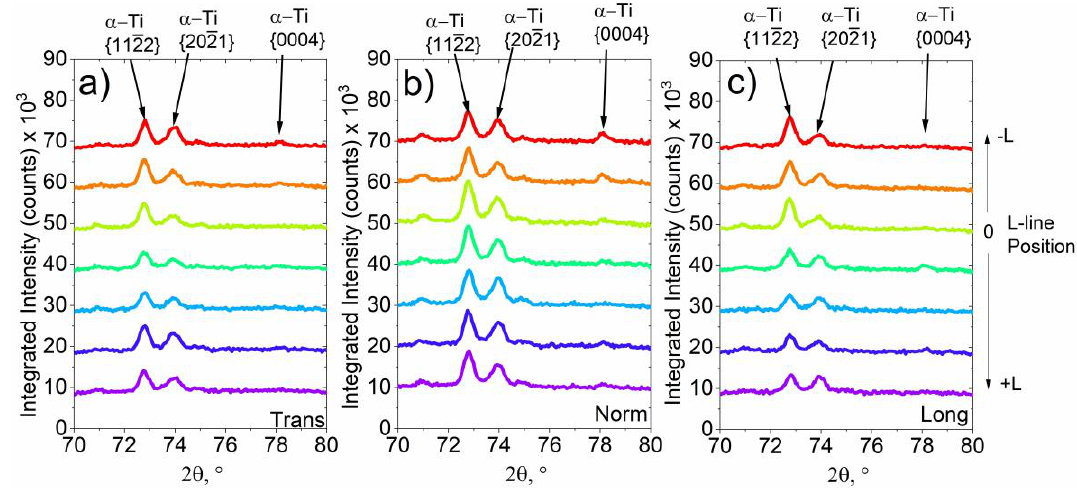
Figure 8. Diffraction patterns along the L-line for ( a ) transversal component, ( b ) normal component, ( c ) longitudinal component.